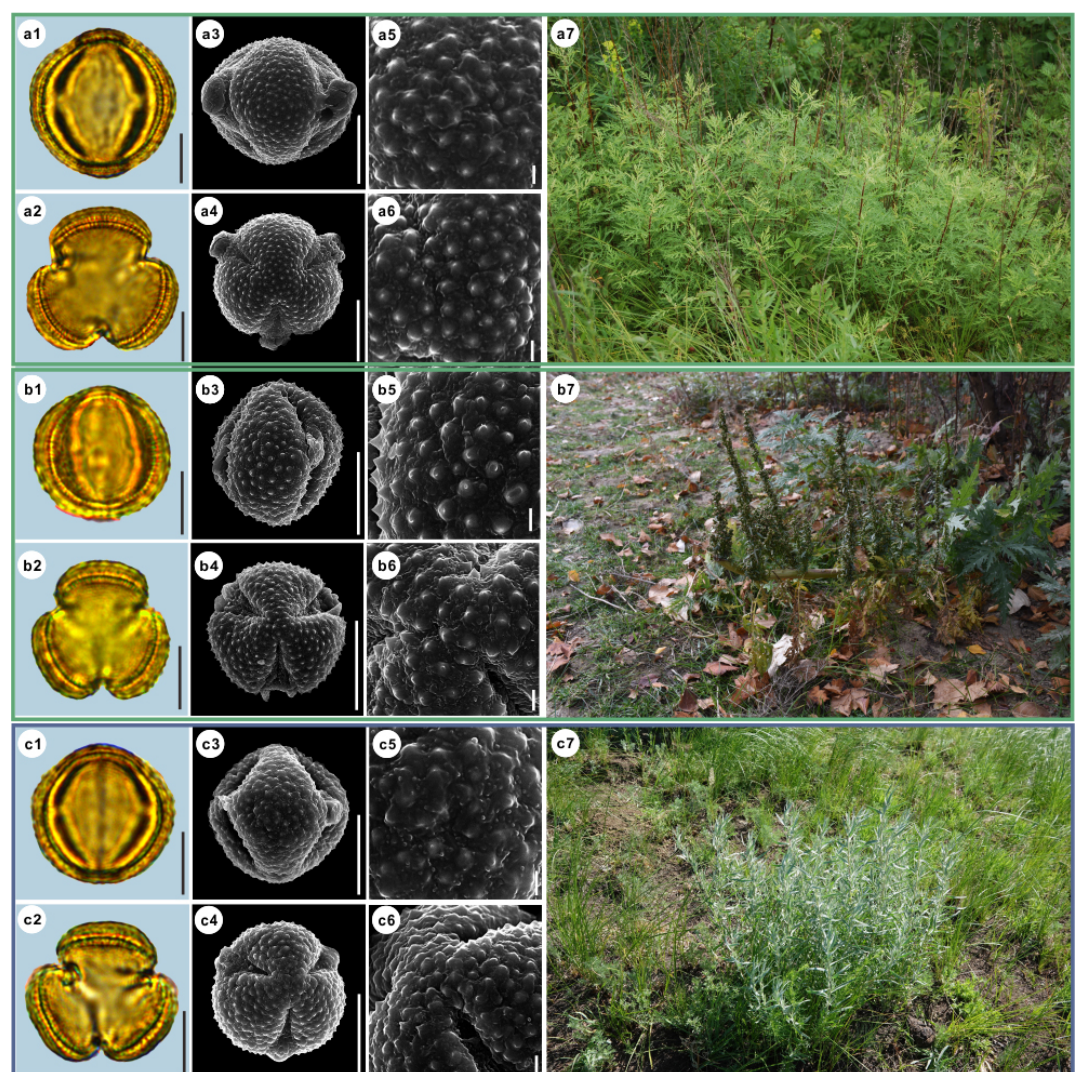
Figure 12. Pollen grains and the habitats of their source plants. (a) Artemisia tanacetifolia ; (b) Artemisia tournefortiana ; and (c) Artemisia dracunculus . Pollen grains in equatorial view under LM (a1, b1, c1) and SEM (a3, a5, b3, b5, c3, c5) , in polar view under LM (a2, b2, c2) and SEM (a4, a6, b4, b6, c4, c6) , along with the habitats of their source plants ( a7 cited from https://www.inaturalist.org/photos/78902853, last access: 19 August 2022, by © Alexander Dubynin, b7 provided by © Chen Chen, c7 cited from https://www.inaturalist.org/photos/76312868, last access: 19 August 2022, by © Anatoly Mikhaltsov). Scale bar in LM and SEM overview 10µm, and in SEM close-up